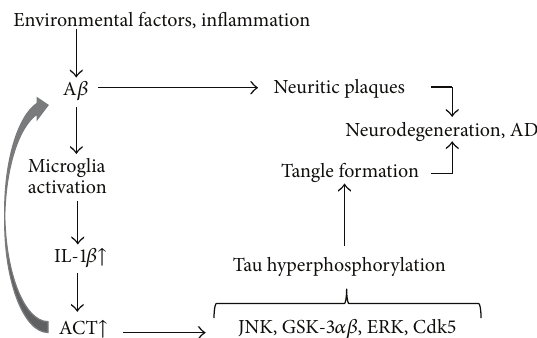
Figure 5: Schematic showing the inflammation-associated mech- anisms in tau phosphorylation and tangle formation in brain: environmental factors, injury to brain, or enhanced inflammation induce A 𝛽 generation as well as microglial activation which leads to increased generation of IL-1 𝛽 (cytokine) which in turn has been shown to enhance ACT expression. ACT has been shown to induce tau hyperphosphorylation through activation of GSK-3 𝛼𝛽 , or ERK (earlier studies) or JNK (data presented here). This may lead to enhanced tangle formation and neurodegeneration. ACT already has been shown to enhance A 𝛽 aggregation and accelerated plaque formation, whether it enhances tau aggregation and tangle formation needs to be